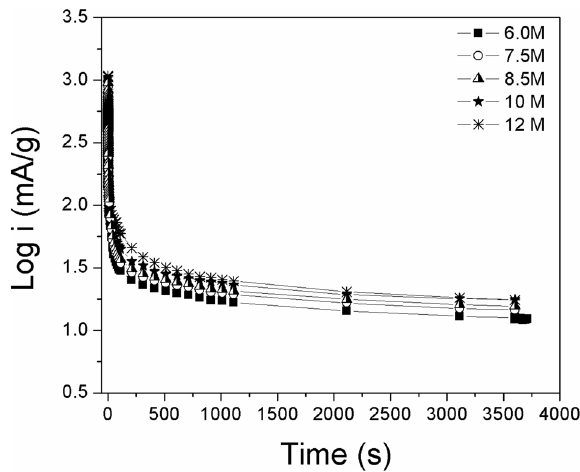
Fig. 7 Plot of the anodic current density vs. discharge time of the La 0.6 Sr 0.4 Co 0.2 Fe 0.8 O 3 electrode at various electrolyte concentrations and